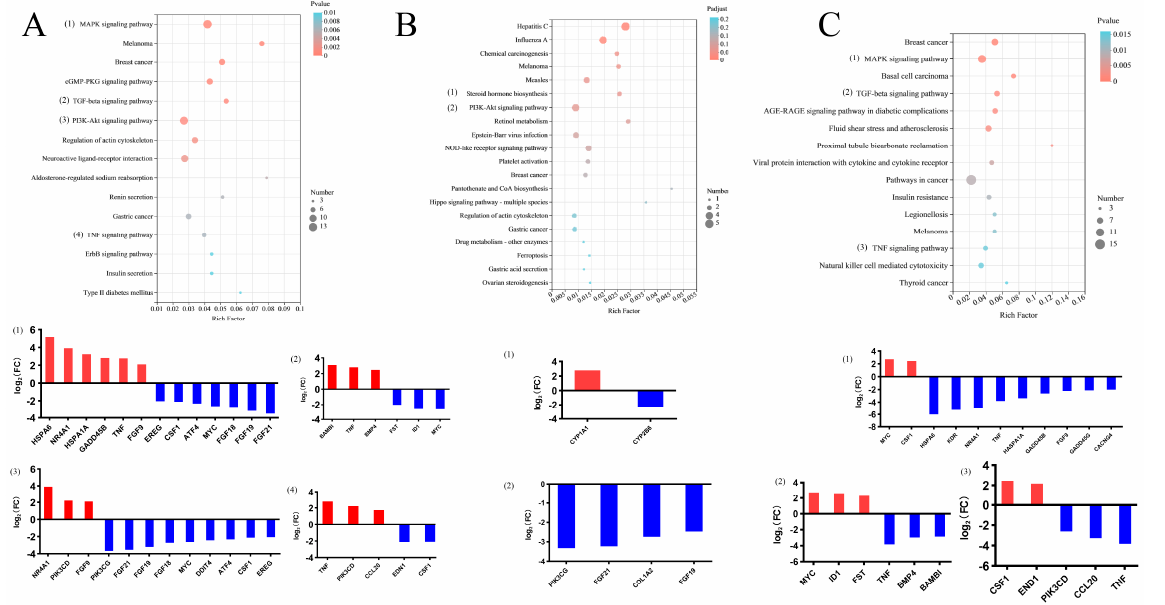
Figure 3. Kyoto Encyclopedia of Genes and Genomes (KEGG) analysis of the three groups. The top fifteen KEGG pathways significantly enriched in control vs. SARA ( A ), control vs. ARA ( B ), and SARA vs. ARA ( C ) and DEGs in the main KEGG pathways. The significance of the identified KEGG pathways was determined by p < 0.05. Red bars indicate upregulated genes and blue bars indicate downregulated